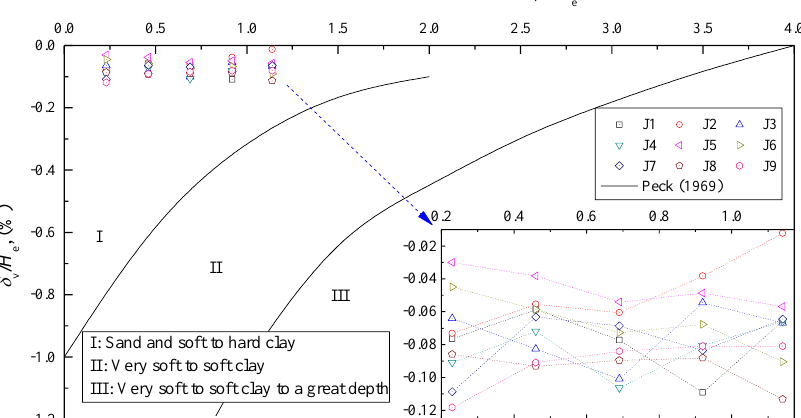
Figure 13. Normalized settlement profiles behind the wall.